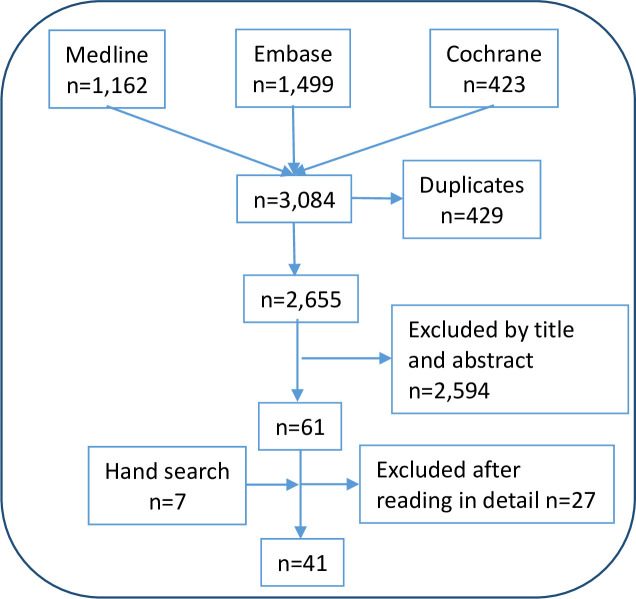
Studies flow-chart.